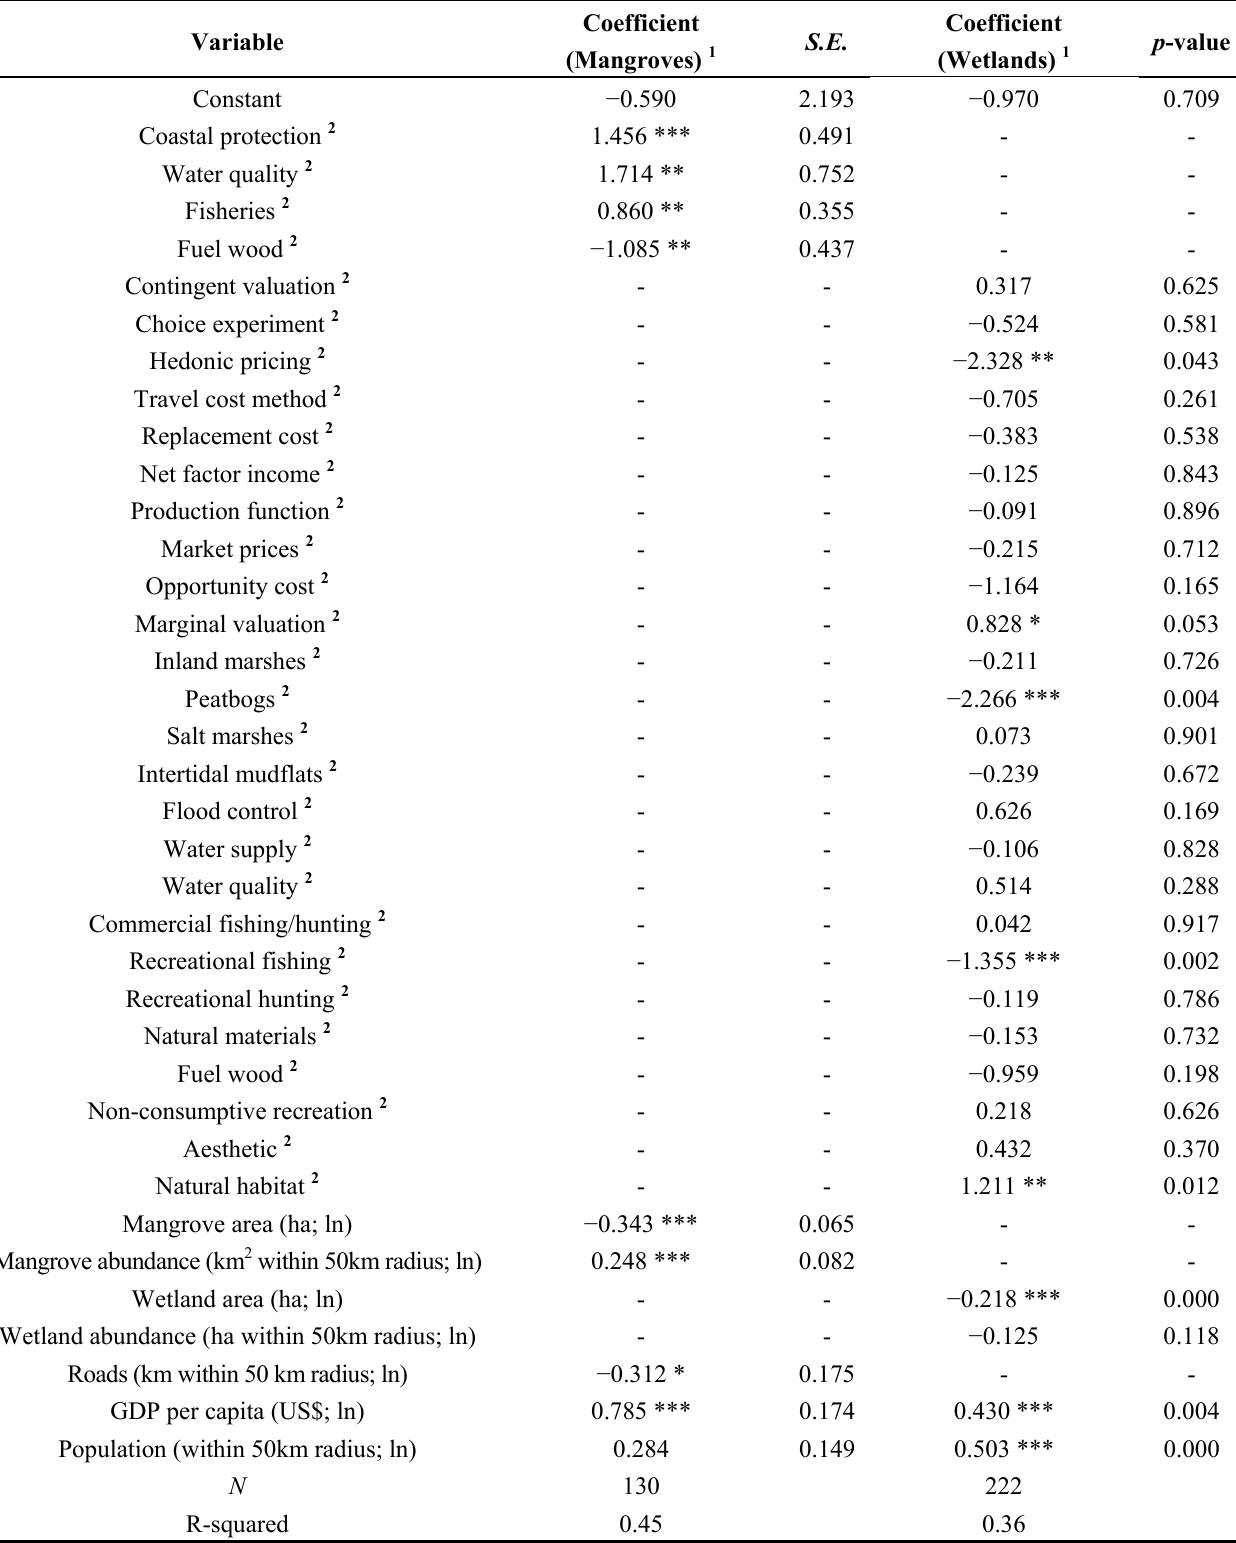
Table 1. Meta-analytic value functions for mangroves, and coastal and freshwater wetlands. The dependent variable is the natural log of the dollar value per hectare per year for the respective